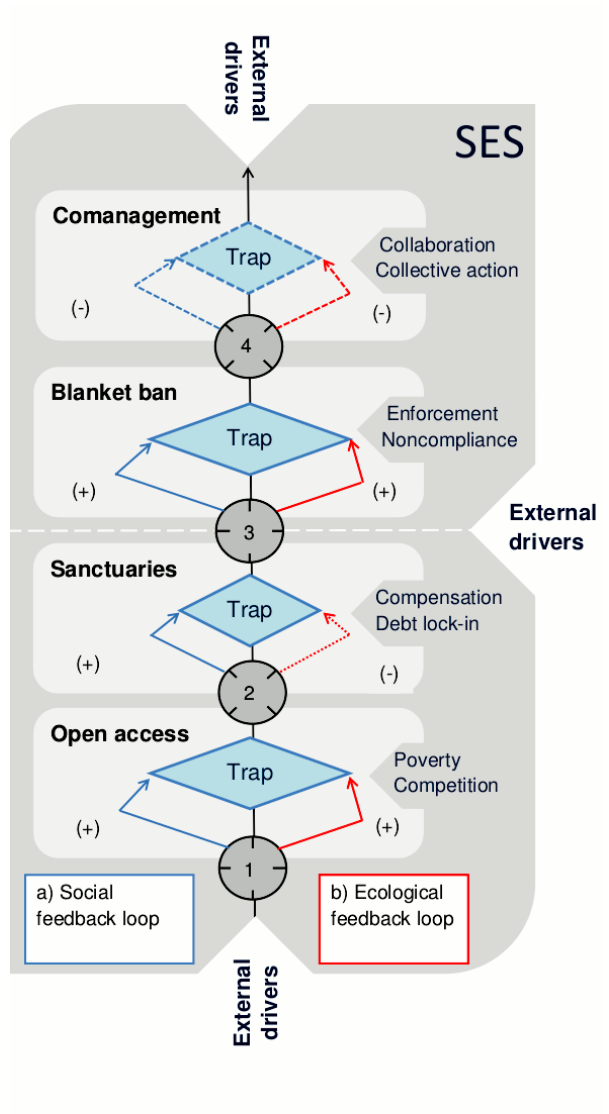
Fig. 2. A conceptual model of critical junctures in the past, leading toward SES configurations of (1) open access; (2) incentive-based approach, and potential future junctures leading toward (3) blanket ban; (4) comanagement. Social and ecological feedbacks (dashed lines and arrows) in the corresponding SES configurations reinforce (+) or alter (-) and ultimately may disrupt trap dynamics. Gray arrows pointing into the configurations are key endogenous drivers of trap dynamics in each